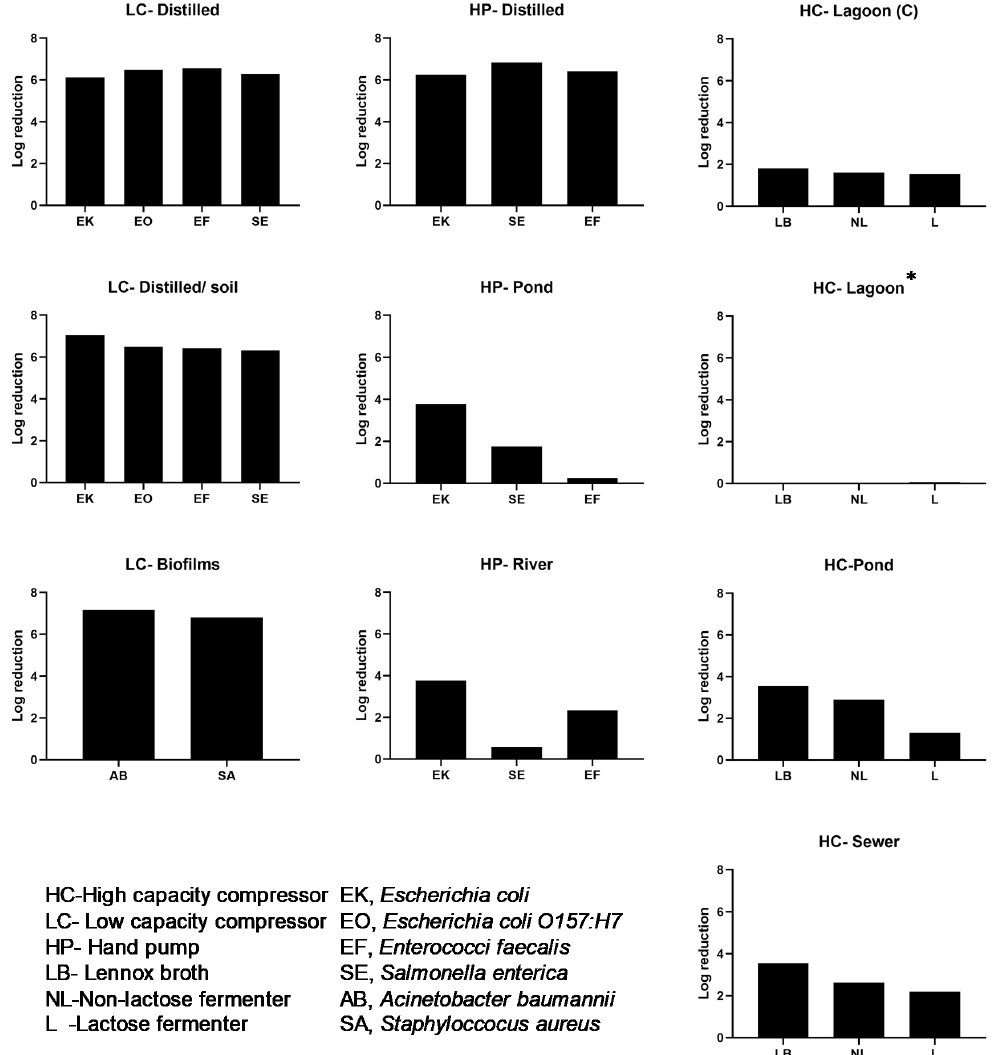
Figure 4. Log reduction following iodine treatment. Left panel : results after use of the low capacity compressor configuration to treat distilled water (LC-Distilled) inoculated with common water pathogens, distilled water plus loess soil (LC-Distilled / soil) and distilled water with biofilms (LC- Biofilms). A 6 log reduction of pathogens was observed using this system. Middle panel : results after use of hand pump configuration to treat distilled water (HP-Distilled), water from naturally occurring water bodies (HP-Pond) and (HP-River) inoculated with and common water pathogens. Organic content in pond and river water reduced e ffi cacy of the device. Right panel : high capacity compressor configuration was used to treat water from naturally occurring water bodies (lagoon (HC-lagoon (centrifuged) and (HC-lagoon) pond (HC-pond) and sewer (HC-Sewer)) to simulate use of the technology in real settings with high particulate matter or organic matter. Even in the presence of increased iodine concentration organic matter still reduced e ffi cacy of iodine. * cfu mL − 1 used to determine log reduction was estimated by using a 6X6 drop-plate method with a limit of detection between 7–18 CFU / mL − 1